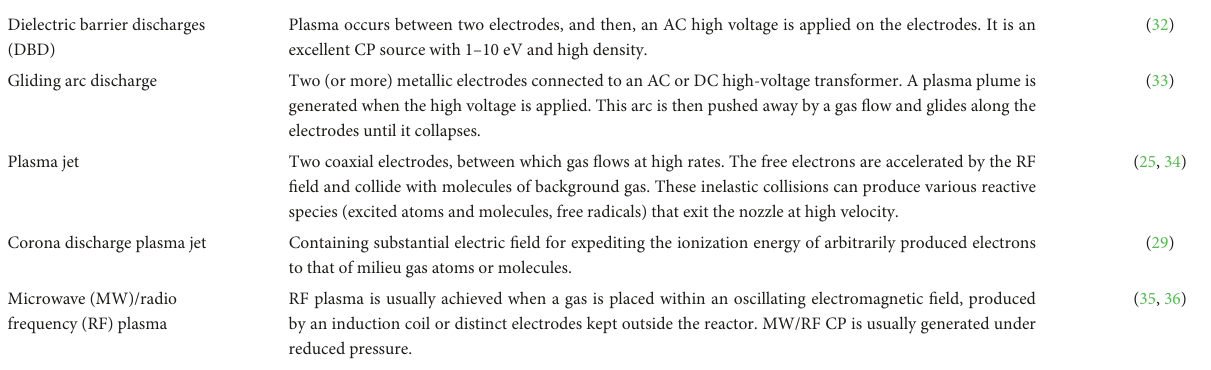
Generating mechanism and characteristics